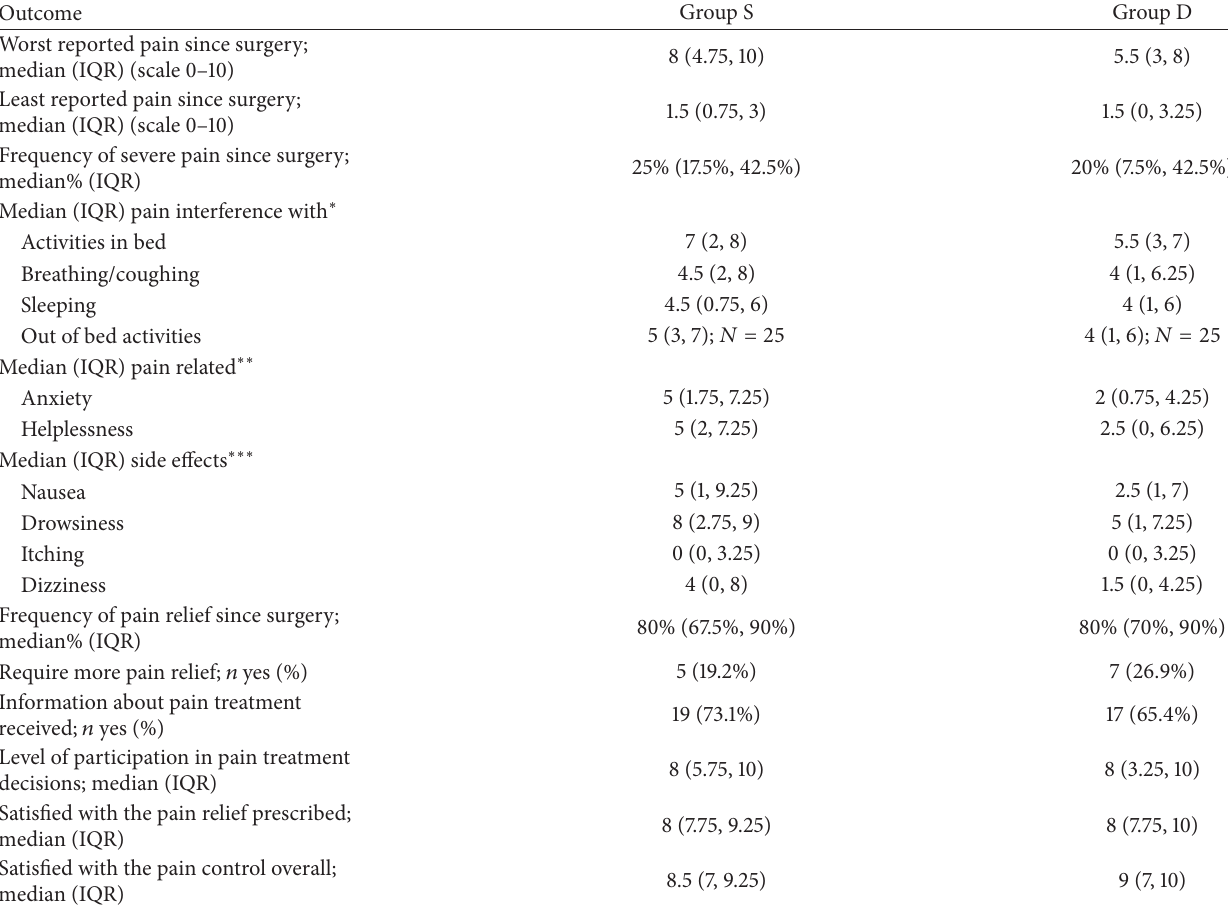
Table 6: Efficacy analysis: study feedback (information obtained from the 48-hour